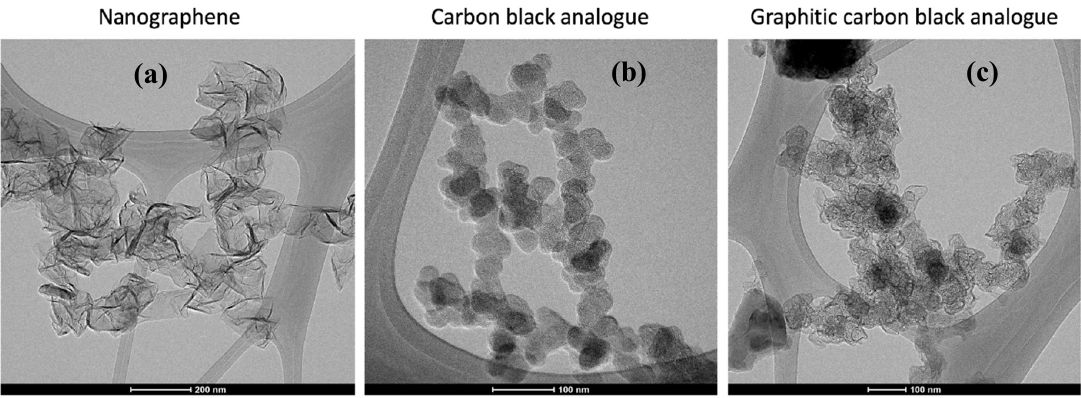
Figure 1. TEM images of ( a ) nanographene (NG), ( b ) amorphous carbon black analogue (ACBA) and ( c ) graphitic carbon black analogue (GCBA) carbons.